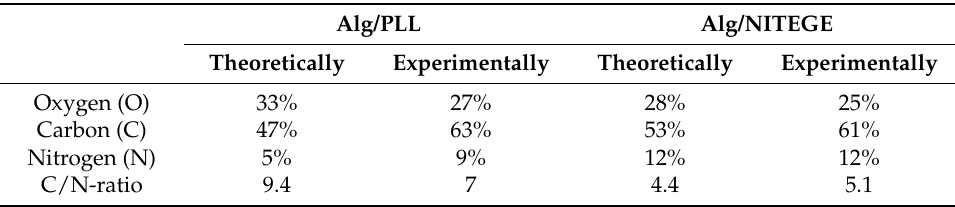
Table 1. Theoretically calculated and by means of X-ray photoelectron spectroscopy (XPS) experimentally determined atomic concentrations of oxygen (O), carbon (C), and nitrogen (N) of the Alg/peptide nanoparticle coatings (each 1 mg/mL in MilliQ, for Alg/PLL volume ratio 4:1 and for Alg/NITEGE volume ratio 1:1). The content of hydrogen was not considered in the calculations. The carbon/nitrogen ratio (C/N ratio) is reported in addition. Alg/PLL Alg/NITEGE Theoretically Experimentally Theoretically Experimentally Oxygen (O) 33% 27% 28% 25% Carbon (C) 47% 63% 53% 61% Nitrogen (N) 5% 9% 12% 12% C/N-ratio